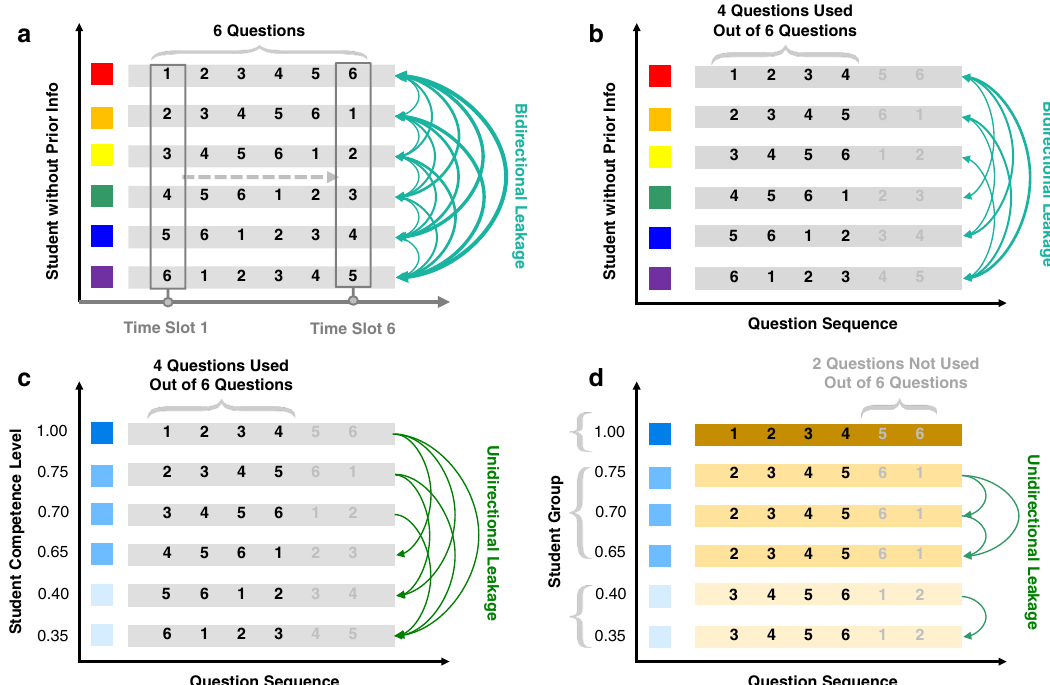
Fig. 1 Anti-collusion mechanisms with and without prior knowledge of students ’ competencies. Assume that collusion happens between two students and one can get answers from the other on questions that the other has already answered or is working on (see “ Methods ” ). a The circulation-based scheme is illustrated with a simple example, in which six students take an exam consisting of six questions ( M 1 = M 2 = 6) provided to each student one by one, and each question must be fi nished within the allocated time slot shown as the vertical box. If there is no information of students' competences, this scheme helps reduce potential bidirectional cheating among students to ~50% of question; b the collusion chance can be made even less if cheating students are fed with more new questions ( M 1 = 4, M 2 = 6); c if prior information on students' competences is available, the naive assignment in b still yields signi fi cant collusion gains; but d , using our grouping-based anti- collusion scheme, the maximum and average collusion gains can be sharply reduced to ~10% and ~3%, respectively. The scheme fi rst divides the competence range into M 2 − M 1 + 1 intervals, then groups the students into these intervals properly, fi nally assigns these groups of students with the corresponding number of consecutive cyclic sequences, respectively. The maximum collusion gain with this scheme is bounded by our Theorem